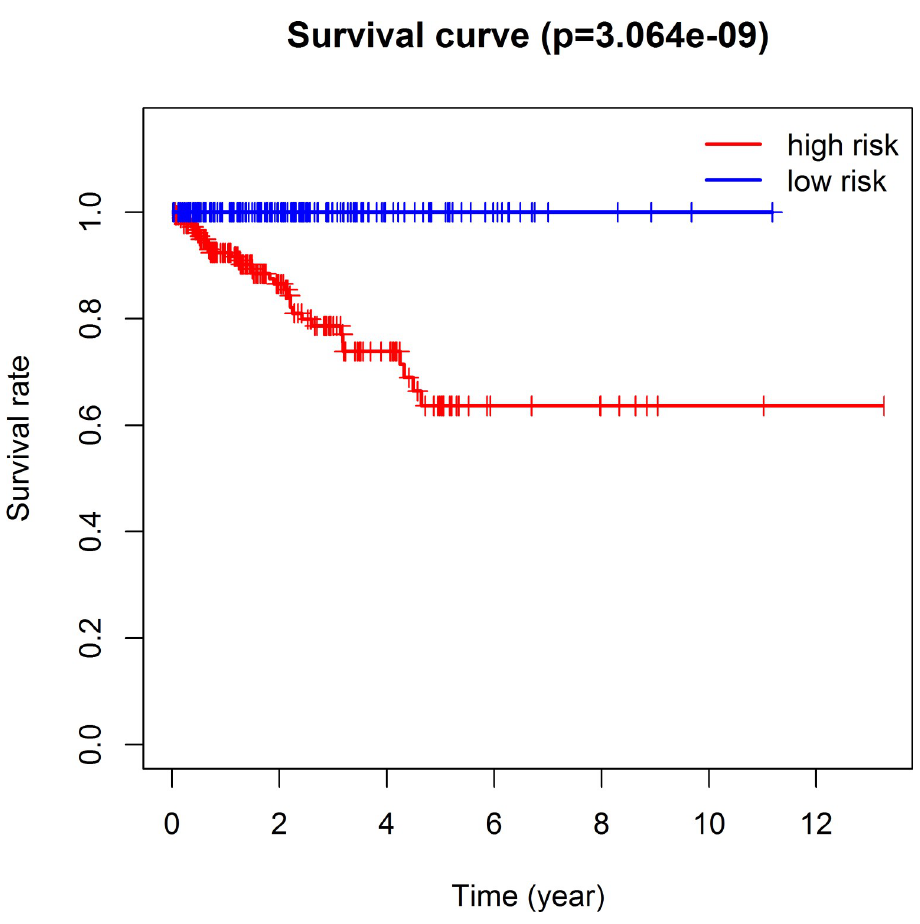
Fig 7. Kaplan-Meier analysis, Log rank P, and C-index were used to evaluate the predictive power of four lncRNA nomogram based on ICGC data.